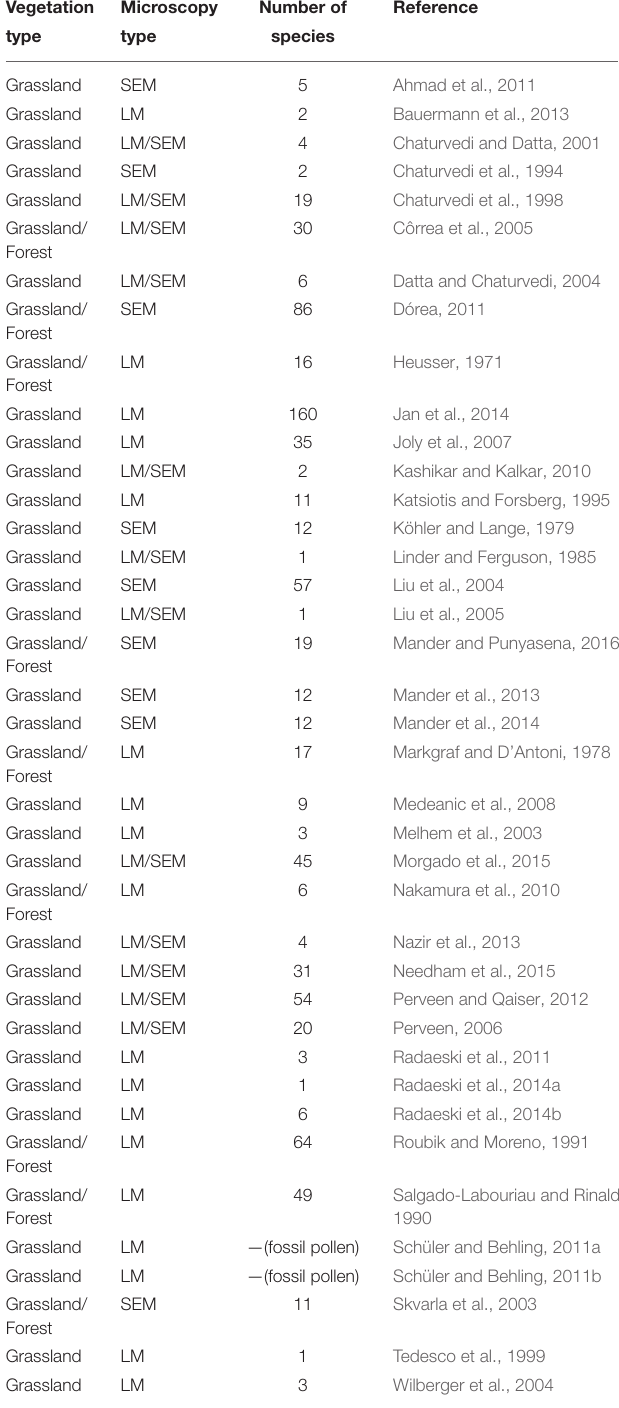
TABLE 1 | Dataset of Poaceae analyzed species, type of microscopy used and vegetation